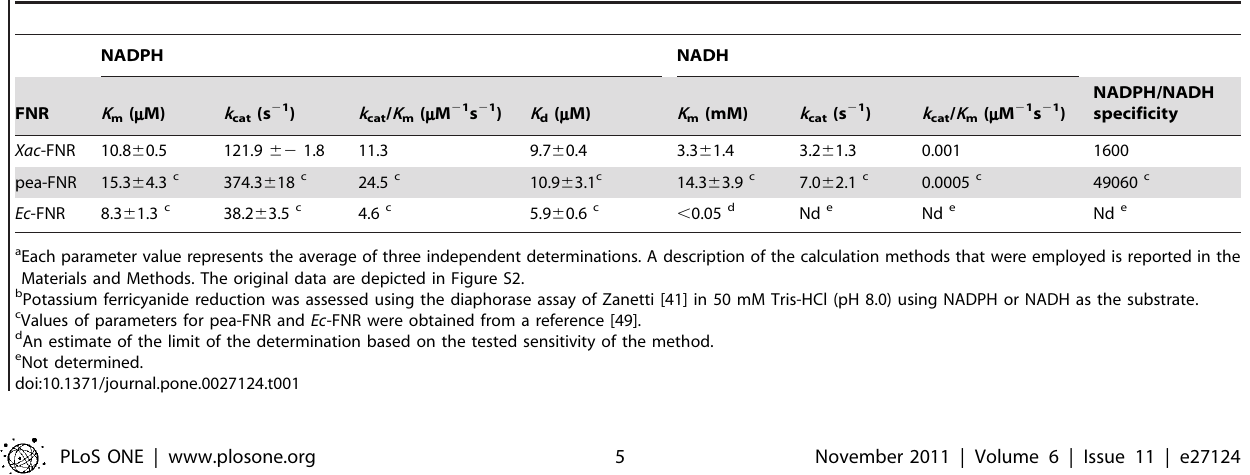
Table 1. Kinetic parametersa of NADPH and NADH diaphorase reactions that were catalyzed by Xac-FNR, pea-FNR and Ec-FNR, and the dissociation constants for the different complexes with NADP +